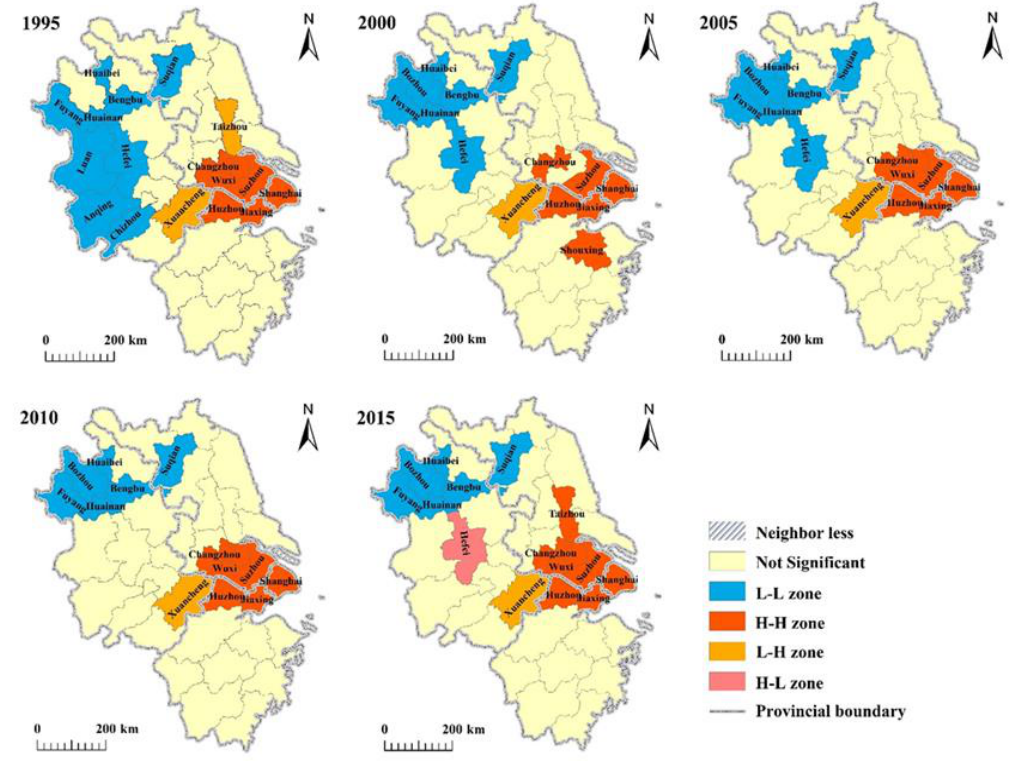
Figure 6. LISA agglomeration maps of the YRD region from 1995 to 2015.